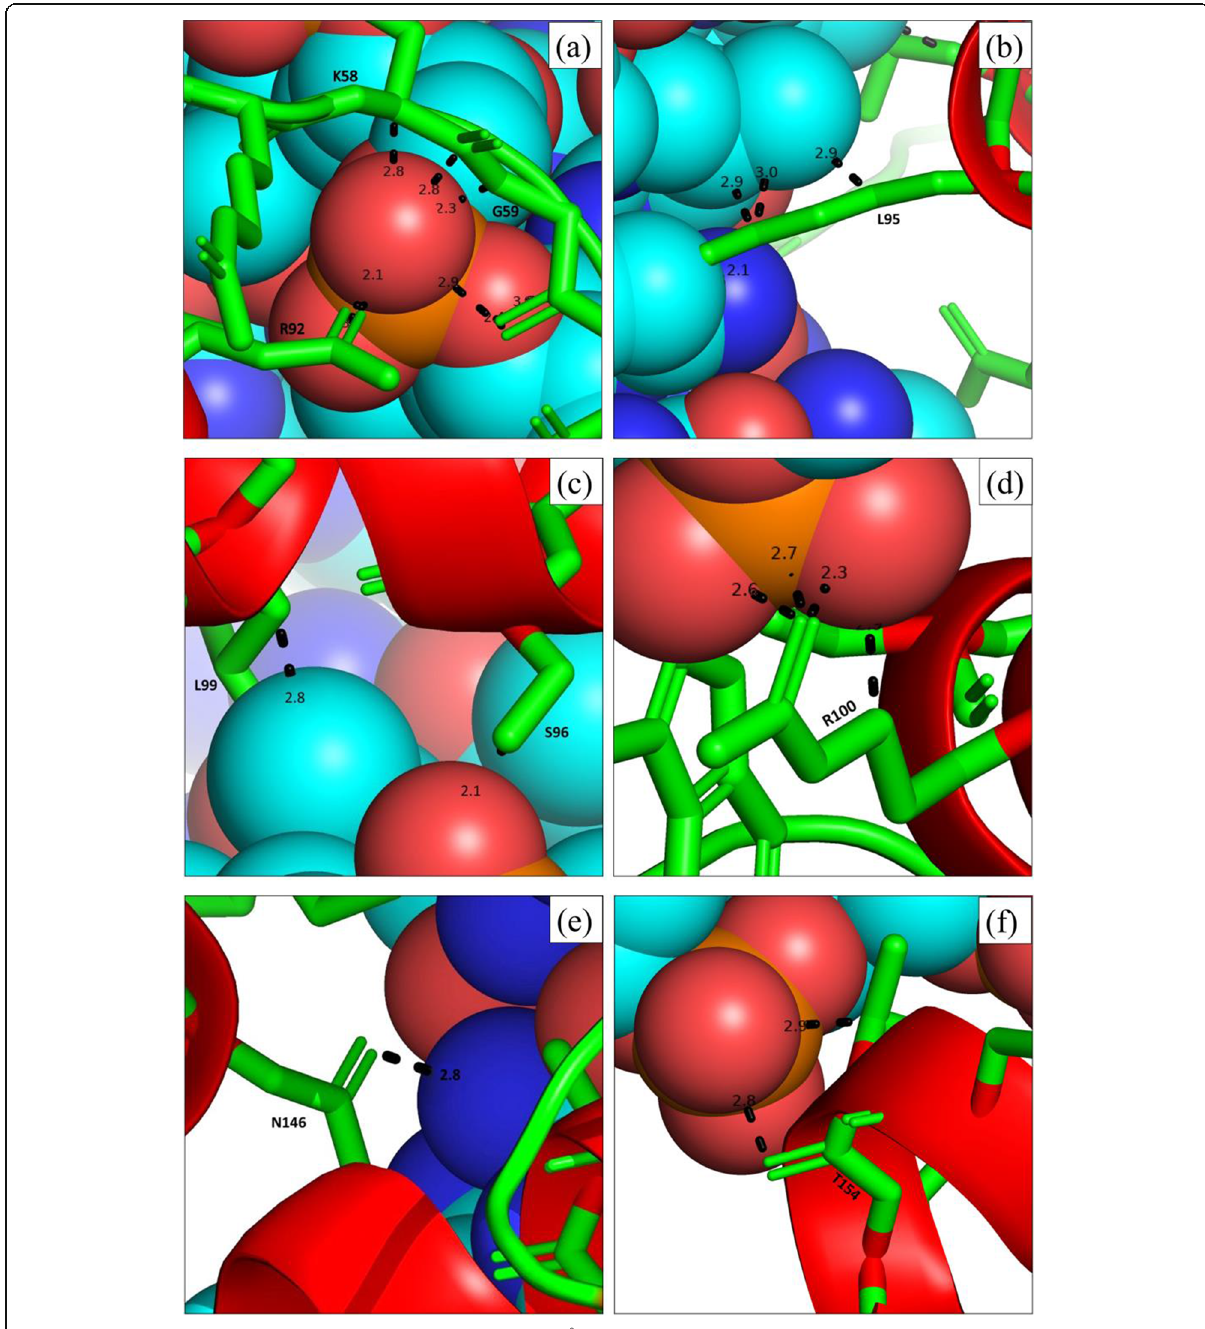
Fig. 4 Predicted binding-site residues on protein OsMYB59 within 3Å. OsMYB59 is shown as cartoon-and-stick form and the DNA is shown as spheres. Here, ( a ) shows K58, G59, and R92, ( b ) shows L95, ( c ) shows S96 and L99, ( d ) shows R100, ( e ) shows N146, and ( f ) shows T154